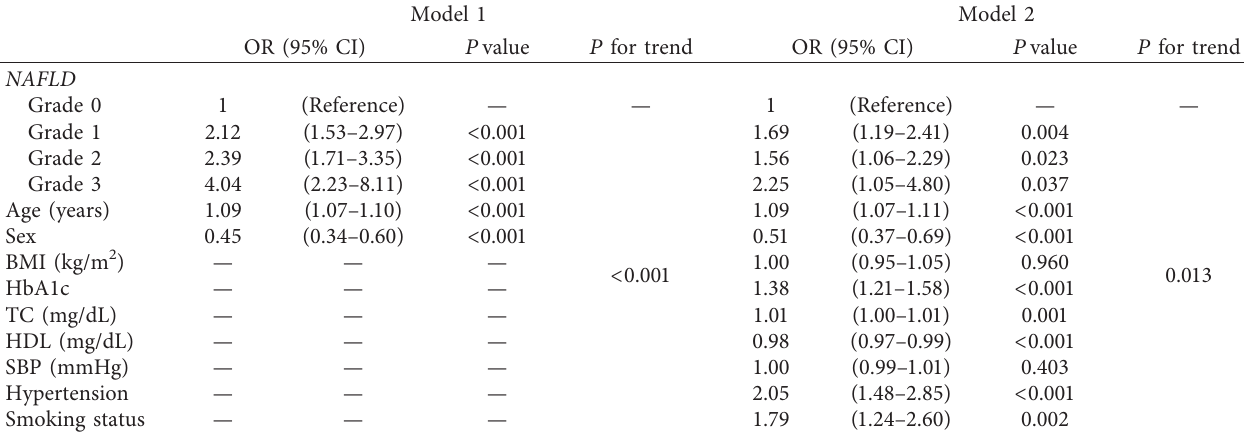
Table 2: Summary of the regression analysis of the correlation between coronary stenosis and